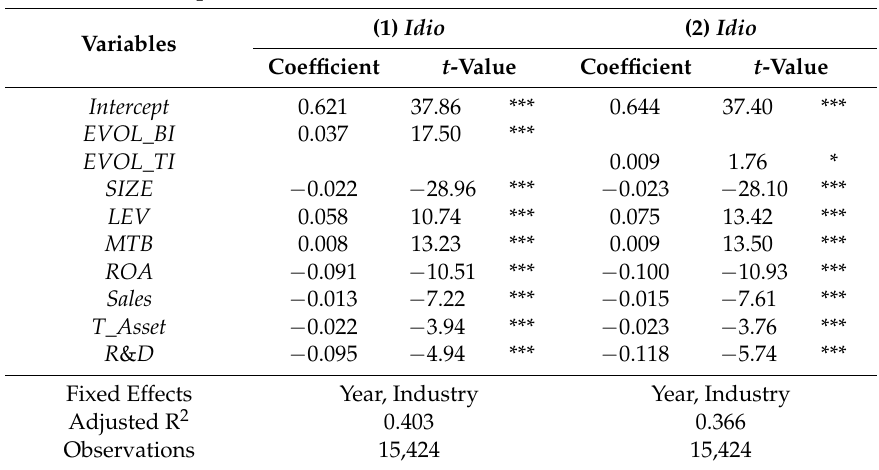
Table 6. The relevance of earnings volatilities to the idiosyncratic risk of stock returns. Panel A: The Separate Test for the Book Income and Taxable Income Volatilities